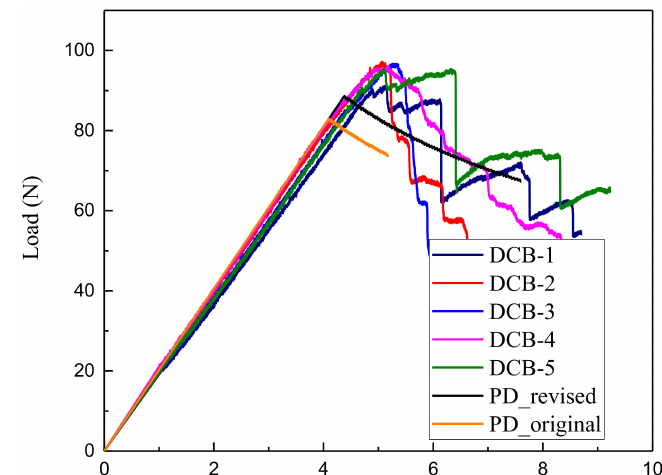
Figure 15. Comparison of load–displacement curve obtained using revised and original bond energy-based failure